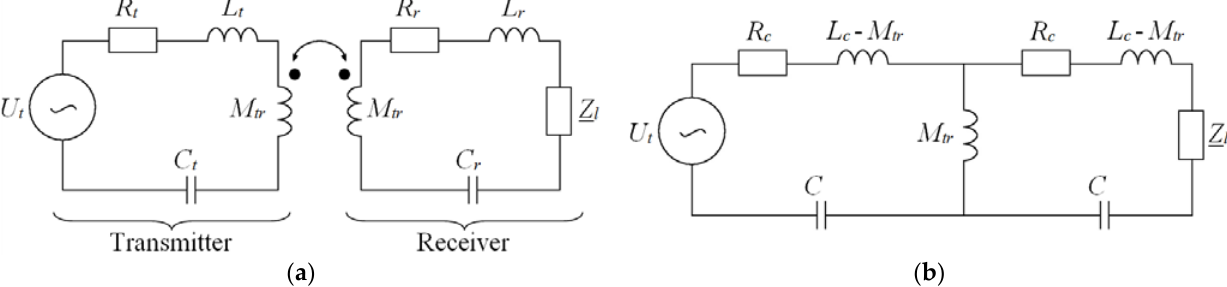
Figure 5. Equivalent circuit of the cell in the periodic WPT system: ( a ) model with indicated magnetic coupling; ( b ) two-port network model of the cell with identical Tx and Rx coils.